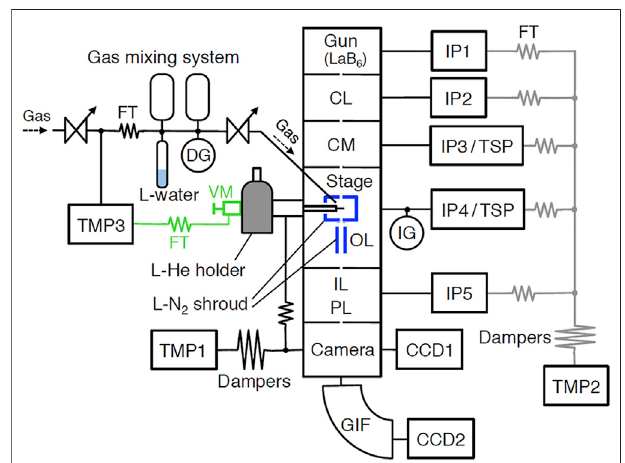
FIGURE 1 | The vacuum system of the UHV-TEM. CL, condenser lens; CM, condenser mini-lens; OL, objective lens; IL, intermediate lens; PL, projection lens; GIF, Gatan Imaging Filter; CCD, charge-coupled device camera;TMP, turbo-molecular pump; IP, ionpump; TSP,Ti-sublimation pump;FT, fl exibletube;DG,diaphragmgauge;andIG,nudeionizationgauge. Black lines show regularly operated lines, and gray lines only roughening. Valve manipulator and FT showed green letters and symbols were removed during TEM